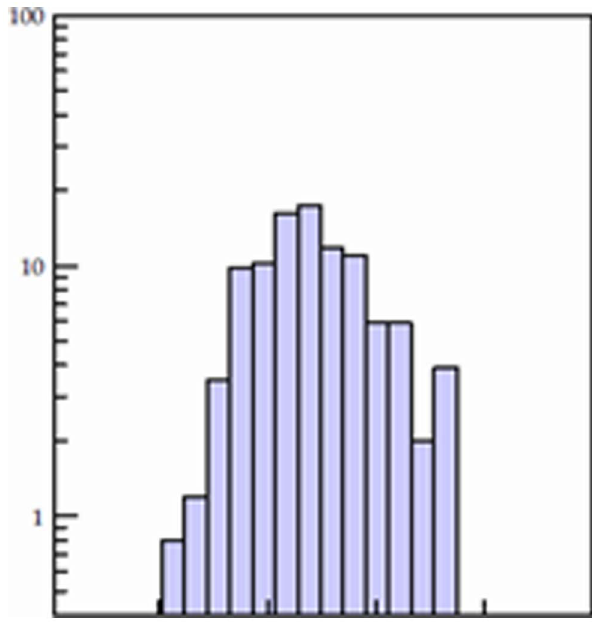
Figure 2. Distribution of the lowest Ki values of the top 255 compounds docked at the HBGA binding sites of the VA387 P dimer.